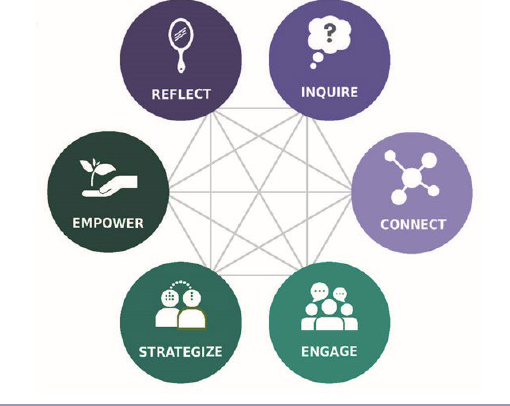
Fig. 1 . The collective leadership model. The six dimensions of this framework outline how sustainability leaders build trust, work with stakeholders to co-produce usable knowledge, and make lasting positive